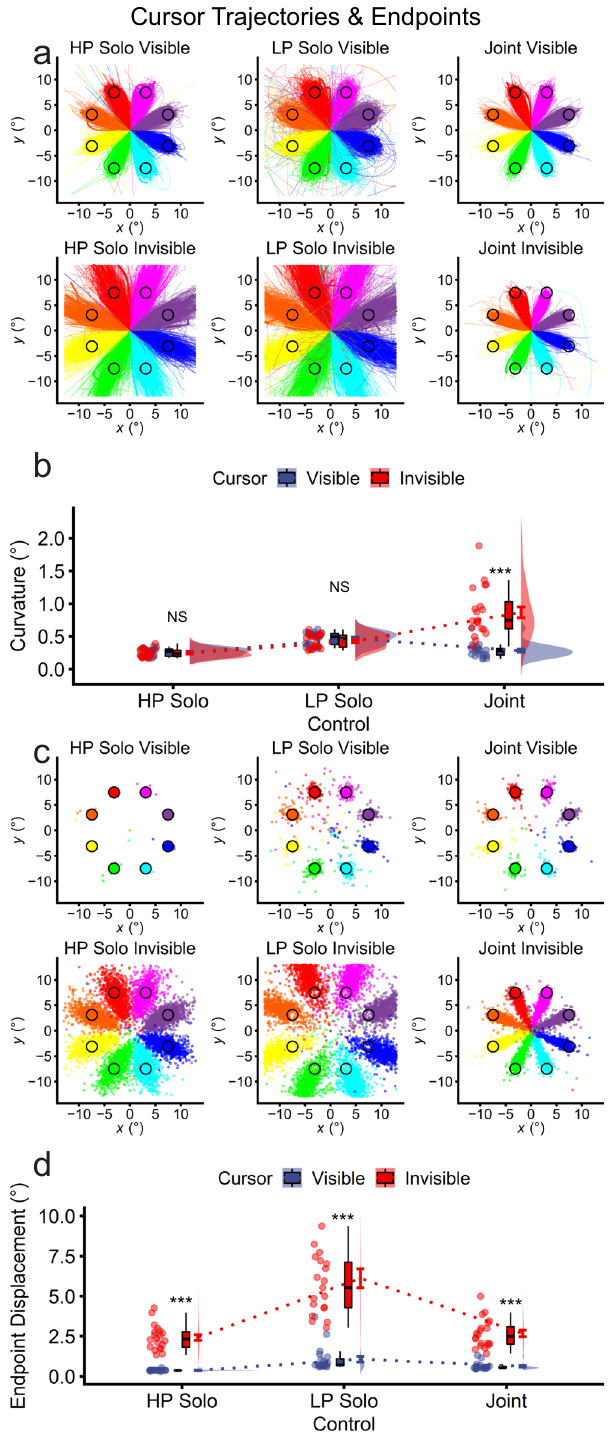
signi fi cantly between solo ( M = 2.41, SD = 0.64) and joint control ( M = 2.45, SD = 0.65; t 16 = − 0.98, p = 0.344; Fig. 4c). By contrast, inter-gaze distance during the action epoch was signi fi cantly smaller for joint ( M = 3.16, SD = 0.65) compared with solo con- trol ( M = 3.44, SD = 0.64; t 16 = 3.66, p = 0.002; Fig. 4d). These results suggested that joint control involved shared attentional gaze between co-actors. Figure 4e shows the relative timing of gaze and cursor positions throughout the trial. Participants moved their gaze fi rst to the target position and then moved the cursor for both